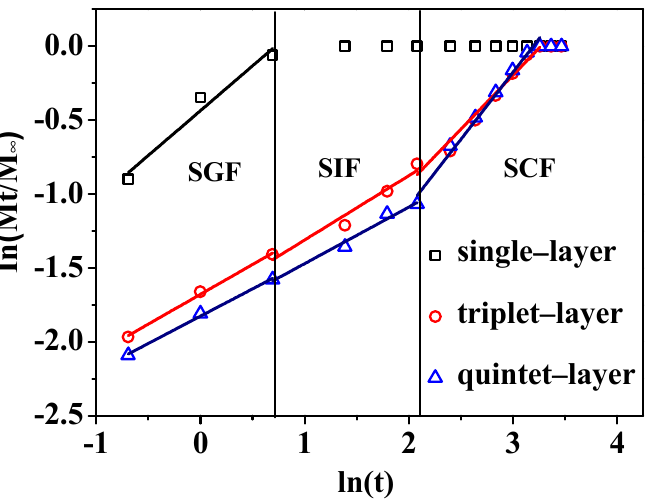
Figure 3. ln(Mt/M ∞ ) vs. ln(t) curve of protein release. Abbreviations: SGF, simulated gastric fluid; SIF, simulated intestinal fluid; and SCF, simulated colonic fluid.